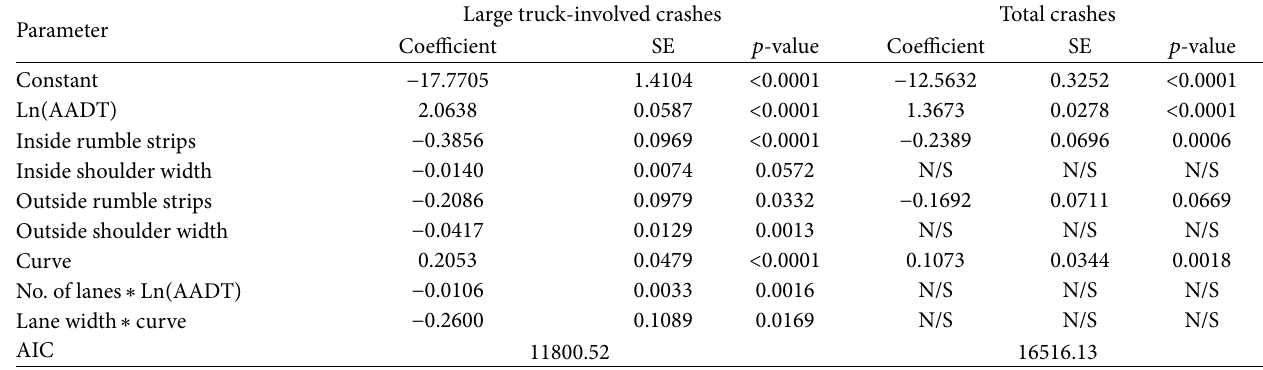
Table 4: Developed NB